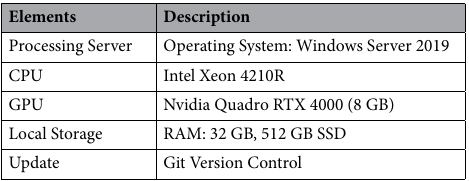
Table 1. Prototype Server. Details w.r.t. established prototype server 20 are shown.